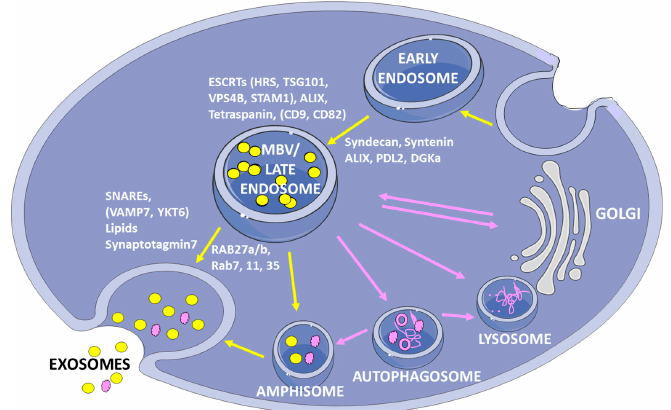
Figure 1. Schematic representation of exosome biogenesis and release. This pathway is traced by yellow arrows and includes exosome biogenesis starting from the invagination of endosome membrane, MBV transport and fusion with plasma membrane. The molecules mainly involved in specific steps of biogenesis are reported (see text for details). Microvesicles degradation rather than secretion is associated to cellular homeostasis, involving autophagosomes that can fuse alternatively with amphisomes (secretory pathway) or with lysosomes (degradation pathway). Homeostatic pathways are indicated by pink arrows.